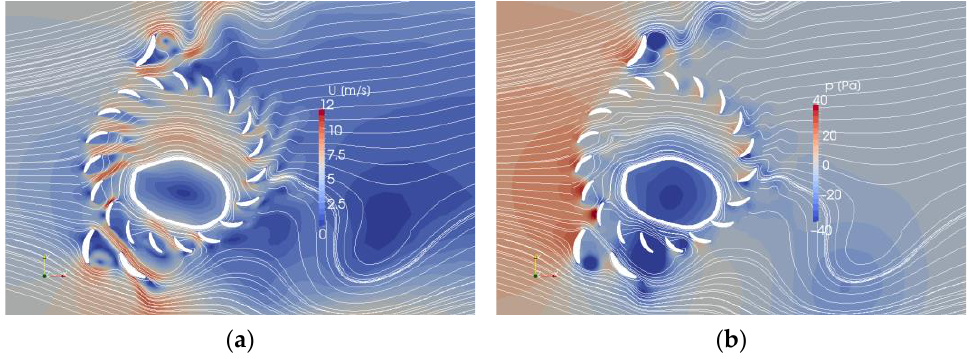
Figure 17. Velocity and pressure distribution and streamlines of the cross-flow wind turbine with